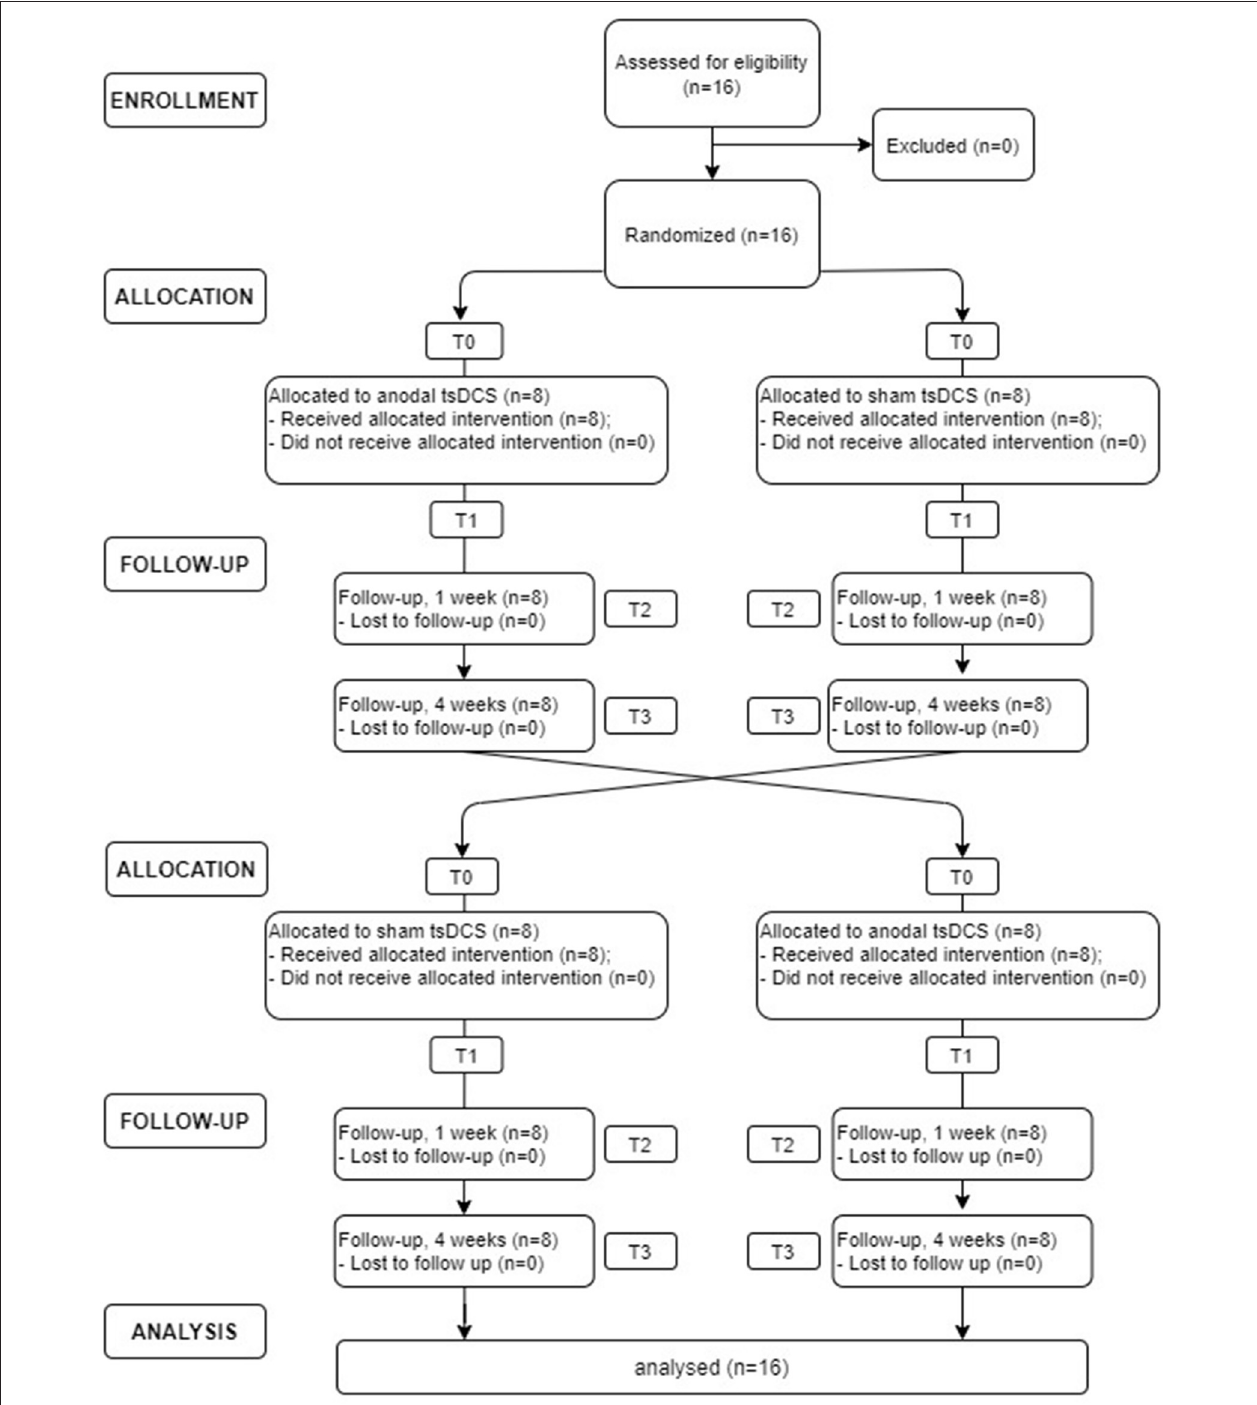
FIGURE 1 | Flowchart diagram depicting the flow of participants through